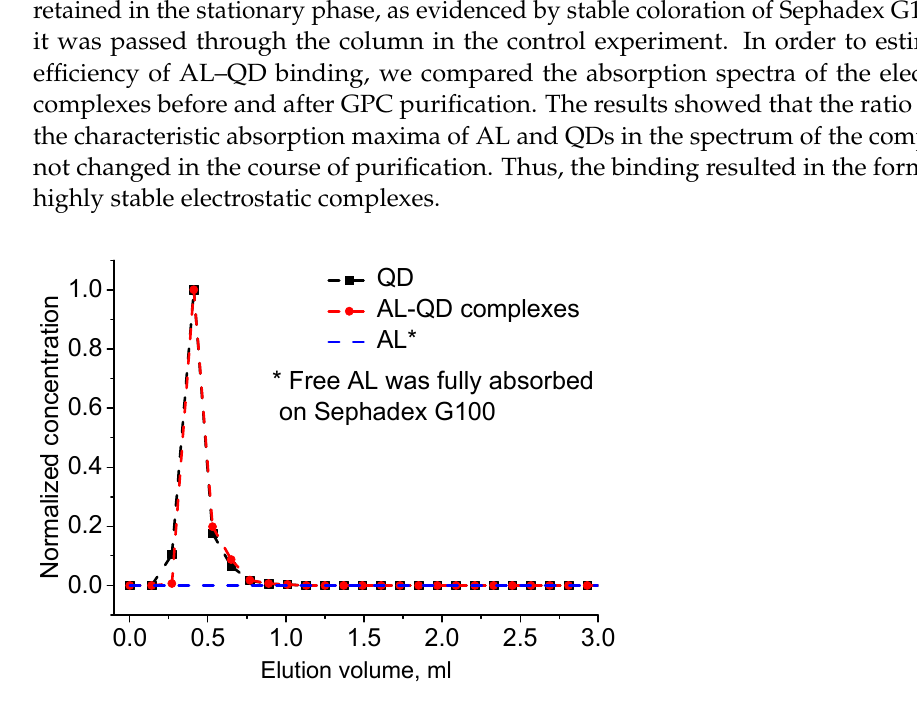
Figure 3. Elution chromatogram of acridine ligand (AL)–QD complexes and their components. GPC with Sephadex G100 as the stationary phase.